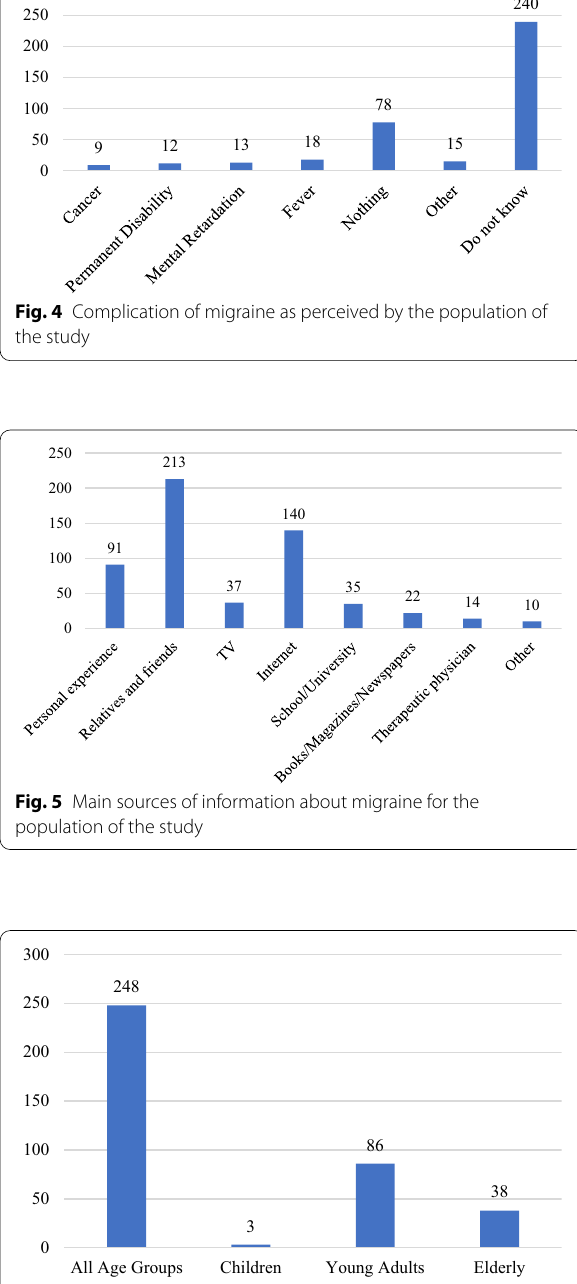
Fig. 6 Average age of migraine patients as perceived by the population of the